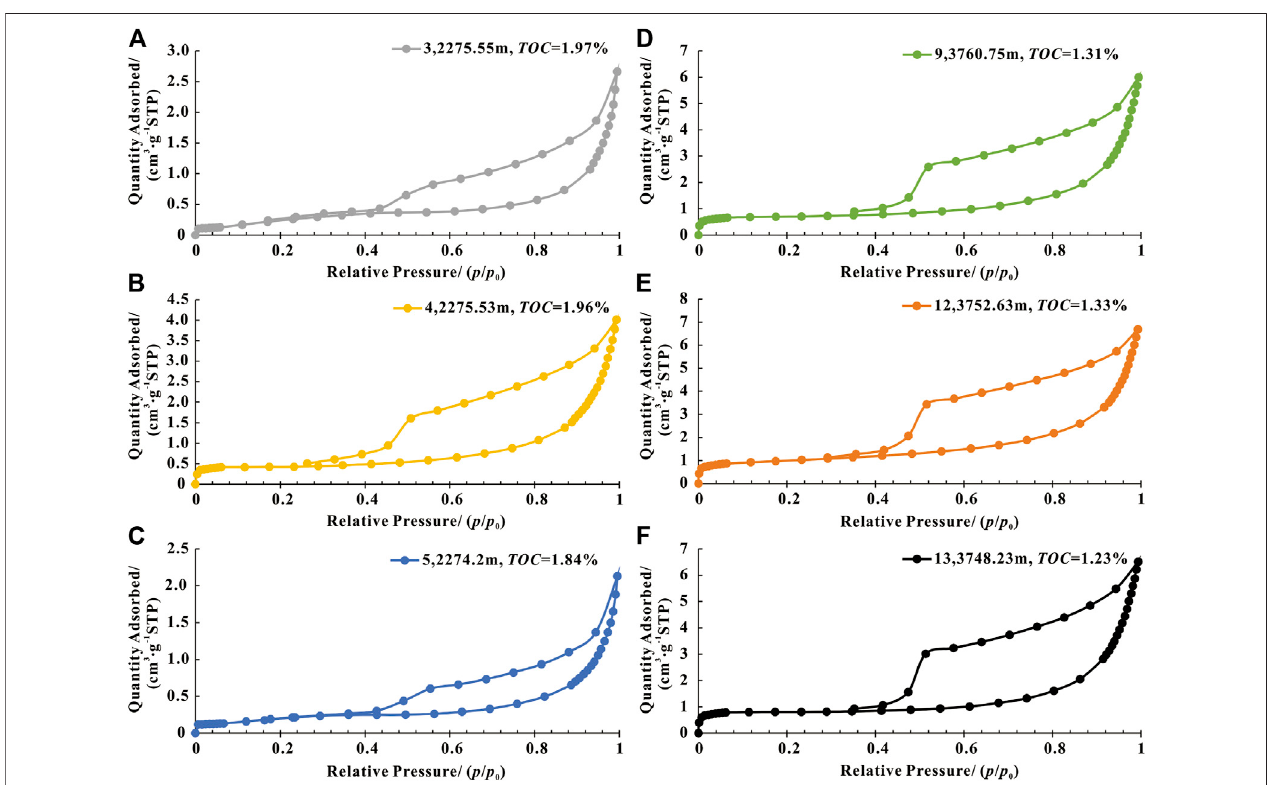
FIGURE7| N 2 adsorptioncurveofcontinental shale in northeastern Sichuan Basin. (A) N 2 adsorptionresult ofFuling areaofDongyuemiaoMember sample no. 3; (B) N 2 adsorption result of Fuling area of Dongyuemiao Member sample no. 4; (C) N 2 adsorption result of Fuling area of Dongyuemiao Member sample no. 5; (D) N 2 adsorption result of Yuanba area of Da ’ anzhai Member sample no. 9; (E) N 2 adsorption result of Yuanba area of Da ’ anzhai Member sample no. 12; (F) N 2 adsorption result of Yuanba area of Da ’ anzhai Member sample no.